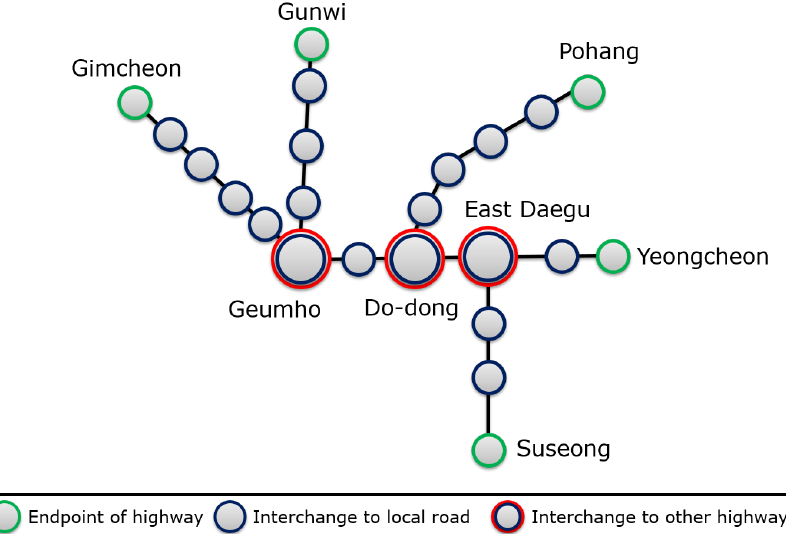
Figure 7. Highway network with city names used in the experiments (the labels represent the name of the